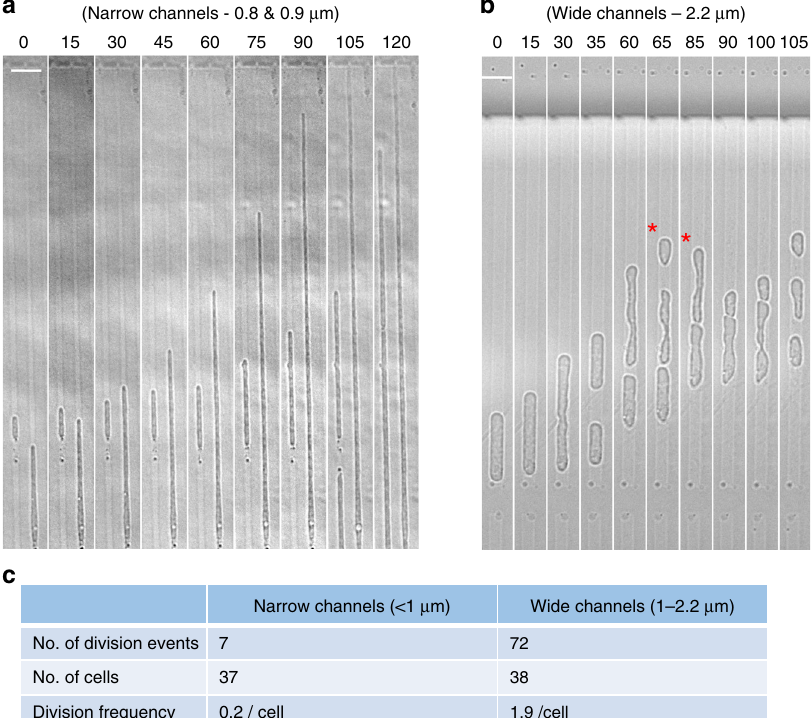
Fig. 2 Effect of channel width on L -form division. a Lack of division in narrow micro fl uidic channels. Selected still bright fi eld images of a time-lapse experiment. L -form cells of strain 4739 (LR2 Ω amyE :: neo hbsU-gfp ) were loaded into micro fl uidic chamber (Chip No. 2; channel widths 0.8, 0.9 and 1.0 µ m) and grown at 32 °C. Images were captured every 5 min. The small cell on the left was in a 0.9 µ m channel; the longer cell on the right was in a 0.8 µ m channel. Full set of still images from this time-lapse series is shown in Supplementary Fig. 2. Scale bar, 5 µ m. The experiment was performed more than three times independently, and multiple positions were imaged in each experiment, with similar results. b In wide channels cell division occurred more frequently. Selected still bright fi eld frames from a time-lapse experiment. The cell shown was in the 2.2 µ m wide channel (Chip No. 7). Red stars label cells that escaped from the channel. Strain: 4739 (LR2 Ω amyE :: neo hbsU-gfp ). Scale bar, 5 µ m. The experiment was performed independently twice, and multiple positions were imaged in each experiment, with similar results. c Division frequency of L-forms grown in narrow vs wide channels. Only ‘ in-channel ’ division events occurred in the fi rst 5 h of the time-lapse experiment were scored. Images from two different experiments were analysed for each channel width [Tabulated